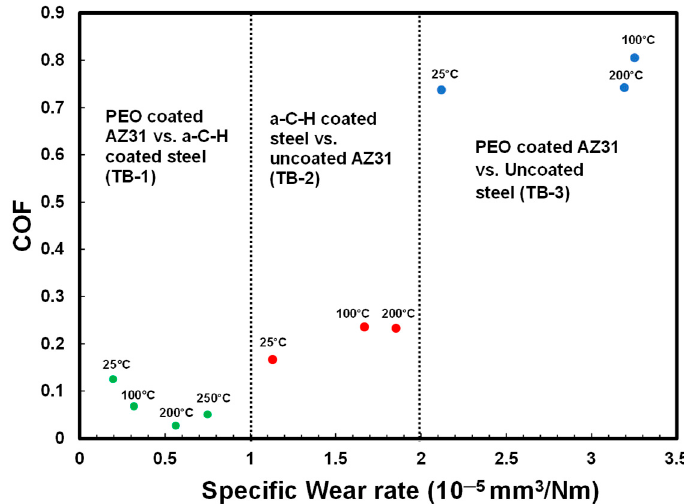
Figure 11. COF vs. wear rate diagram for a-C-H coated steel vs. PEO-coated AZ31, a-C-H coated steel vs. uncoated AZ31 and uncoated steel vs. PEO-coated AZ31 Mg alloy at 25, 100, 200 and 250 ◦ C. The distinct tribological behaviors (TB) displayed by the different tribocouples are referred to as TB-1, TB-2 and TB-3 in the text.